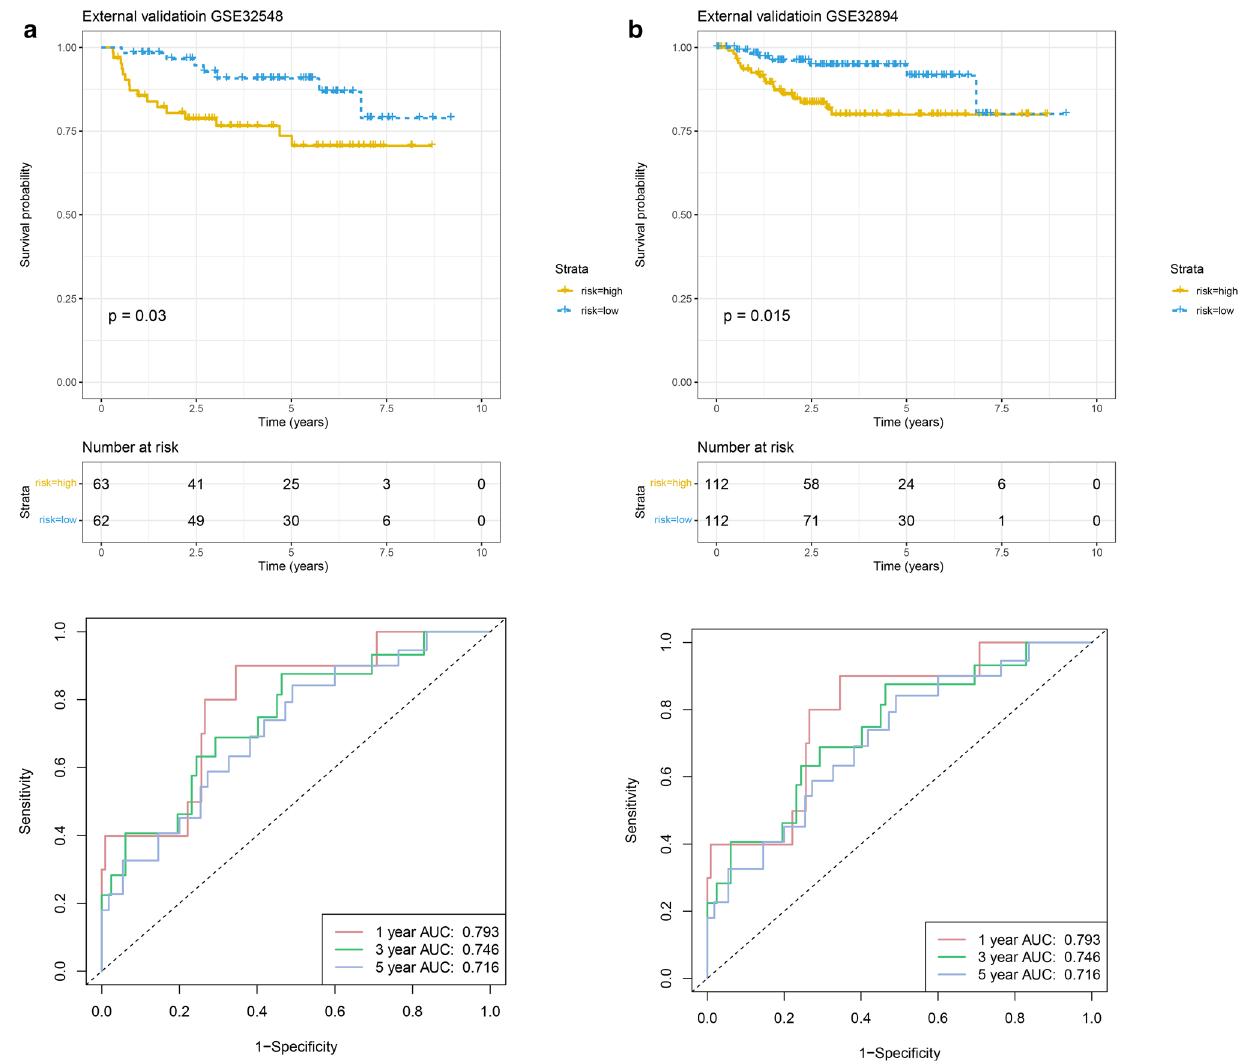
Figure 5. Evaluation of the prognosis prediction power of the five PIRMGs signature in ( a ) GSE32548 and ( b ) GSE32894 by KM survival analysis of the high- and low-risk groups and time-dependent ROC